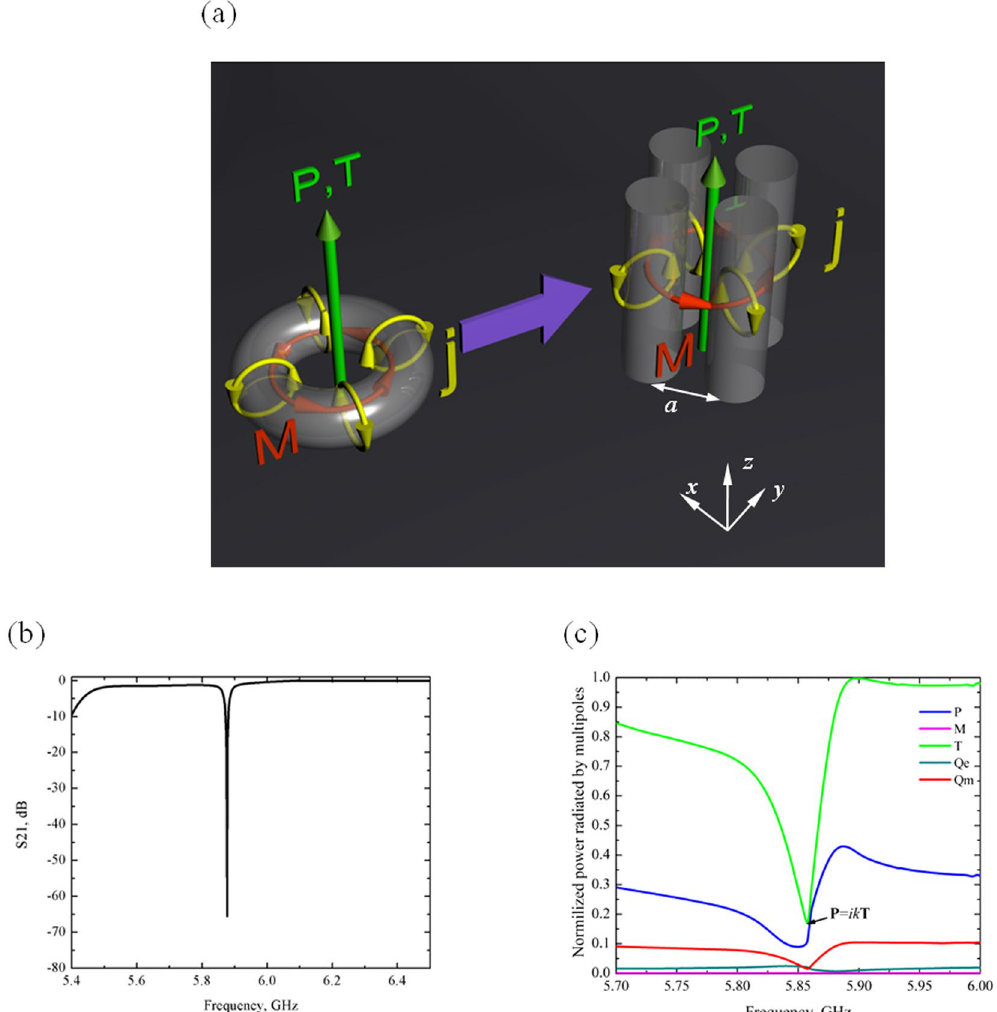
Figure 1. ( a ) Representative toroidal source and an all-dielectric source supporting anapole excitation. Its metamolecule is composed of four closely spaced infinitely long high-index dielectric cylinders. Yellow arrows show displacement currents j induced by the vertically polarized electric dipole antenna ( P ), red arrows show magnetic moments M of the constituent dielectric cylinders, and the green arrow represents the electric field E , toroidal and electric moments. ( b ) The calculated spectrum S21 of power received at second antenna relative to the power input to the anapole source composed of four cylinders, as shown in Fig. 1a. The results correspond to the HFSS simulations. ( c ) Contributions of the five strongest multipole excitations to the radiation of the anapole